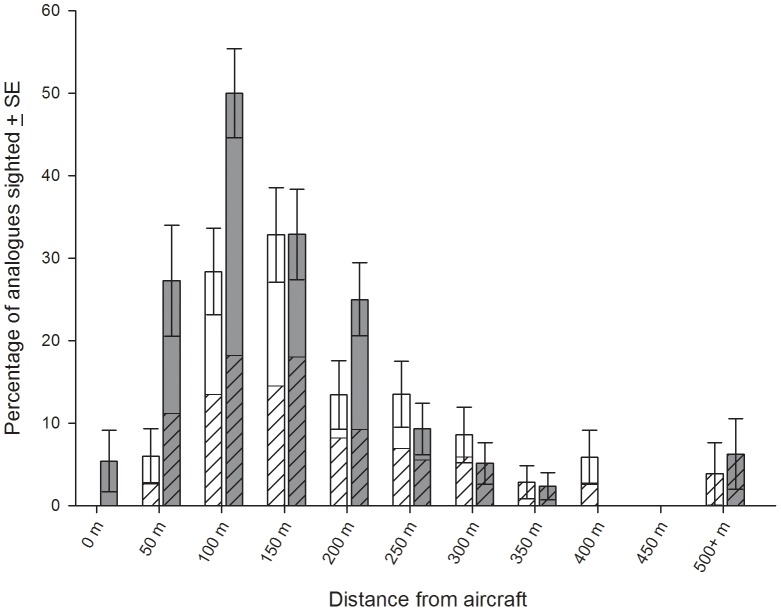
Percentage of validated analogue sightings per aircraft with the relative contribution of different trial treatments.Open bars indicate fixed-wing data, closed bars indicate helicopter sightings. Hashed bars indicates contribution of trials using standard methodology (cruising speed, no orbiting), non-hashed bars indicates contribution of alternative trials (orbiting permitted (fixed-wing), 100 kts airspeed (helicopter)). Contribution of each treatment type has been scaled to account for differences in sample size.